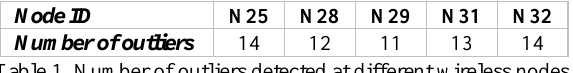
Table 1. Number of outliers detected at different wireless nodes.